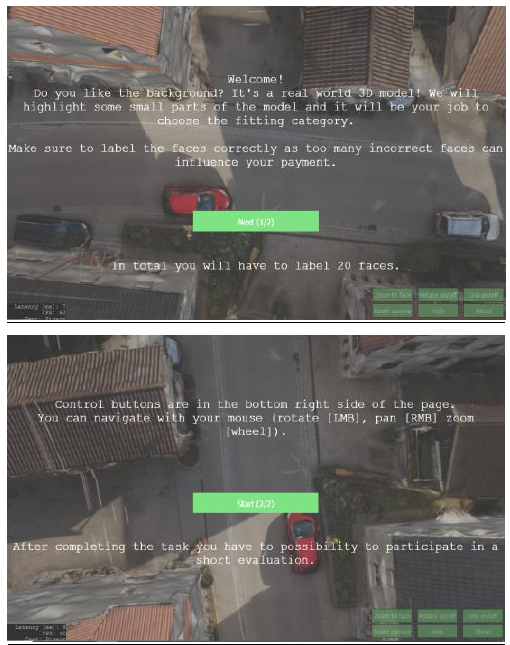
Figure 3 . Introduction pages explaining the crowd job.